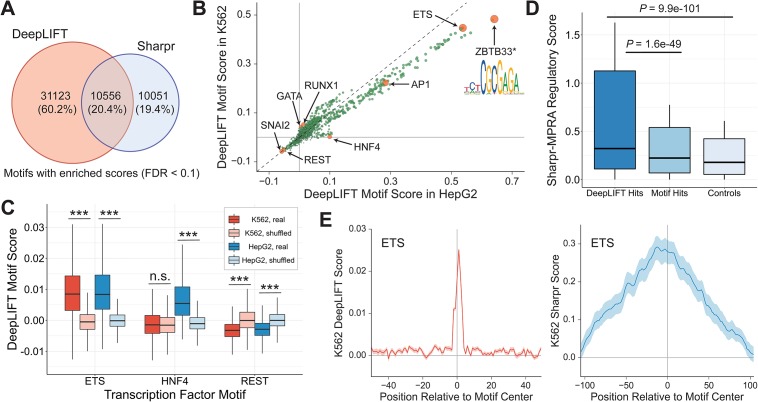
MPRA-DragoNN DeepLIFT feature importance scores robustly predict functional nucleotides.(A) Overlap between significant motif instances (Benjamini-Hochberg FDR < 0.1) identified by DeepLIFT and Sharpr. (B) Scatter plot of average DeepLIFT scores for 1934 motifs in HepG2 (x-axis) and K562 (y-axis) [39]. Orange points are discussed in the text. (D) Sharpr-MPRA nucleotide score distributions for (i) motifs that are also DeepLIFT hits, (ii) all motifs, and (iii) negative control shuffled motifs. (C) Distributions of average DeepLIFT motif scores for ETS, HNF4, REST, and their respective control motifs (shuffled versions) in both K562 and HepG2. ***p < 10−200; n.s., not significant. (E) Positional distribution of DeepLIFT scores (left) and Sharpr scores (right) with respect to the center of ETS motif occurrences. Note that the DeepLIFT plot x-axis ranges from -50 bp to 50 bp while the Sharpr plot ranges from -100 bp to 100 bp. All p-values are computed with the Mann-Whitney U test.